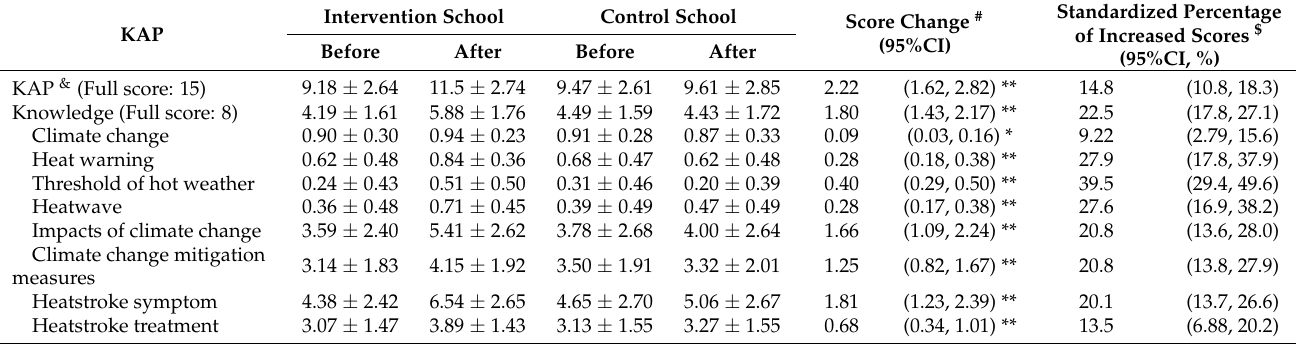
Table 4. Scores of knowledge, attitude, and practice (KAP) for parents of primary students at intervention and control schools before and after intervention and the difference-in-difference (DID) analysis of score